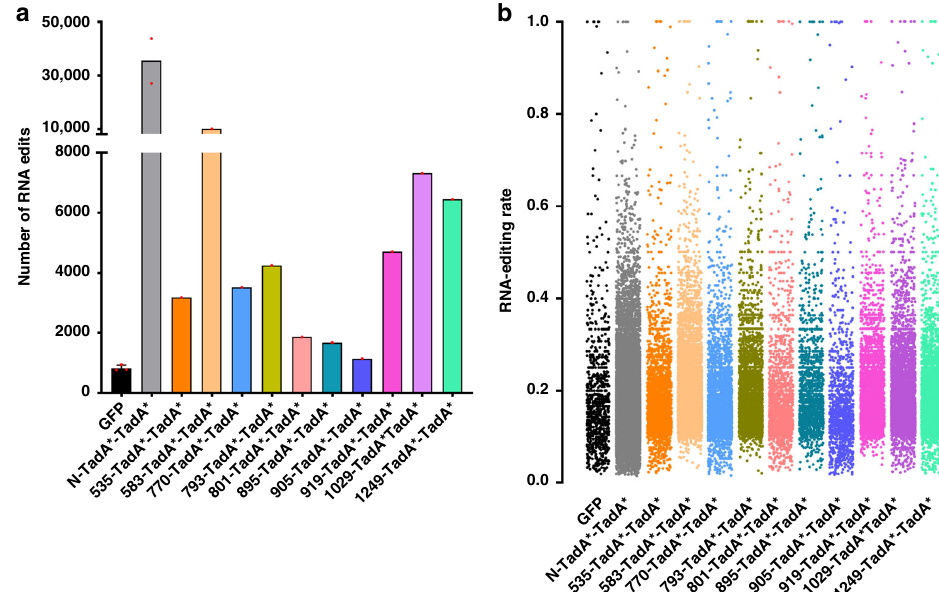
Fig. 3 RNA off-target activities of functional ABE (TadA*-TadA*)-nSpCas9-DS variants and N-terminal counterpart. a Transcriptome analysis showing the number of edited adenine nucleotides in HEK293T cells transfected with functional ABE (TadA*-TadA*)-nSpCas9-DS variants or N-terminal counterpart and sgRNA-1. ( n = 3 biologically independent samples for GFP and data here are represented as mean with S.E.M., n = 2 biologically independent samples for N-TadA*-TadA* and n = 1 for other samples). b Representative jitter plots displaying the RNA A-to-I conversion frequencies at transcriptome level in HEK293T cells transfected with functional ABE (TadA*-TadA*)-nSpCas9-DS variants or N-terminal counterpart and sgRNA-1. Source data are available in the Source data fi